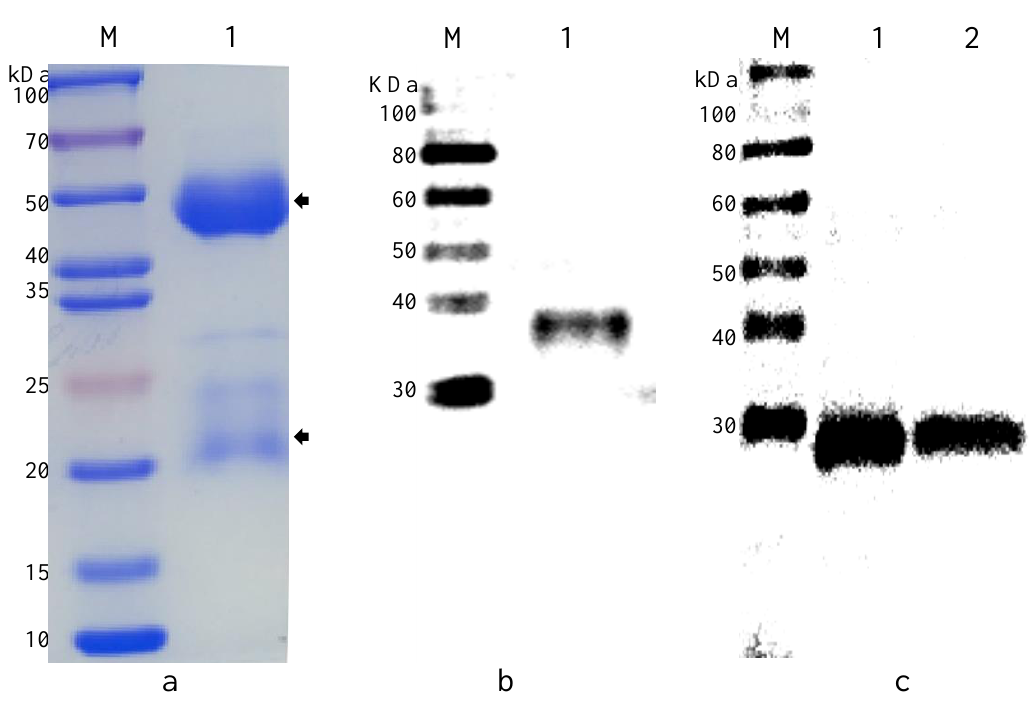
Figure 7. SDS-PAGE and Western blot analysis of PAbs anti-EhSWP3. M: protein molecular weight marker. ( a ) 1: The H-chain and L-chain of PAbs anti-EhSWP3 were marked with black arrows; ( b ) 1: purified recombinant protein rEhSWP3; ( c ) 1: total proteins extracted from EHP spores using SDS extraction method; ( c ) 2: total proteins extracted from EHP-infected hepatopancreas tissue of shrimp using SDS extraction method.